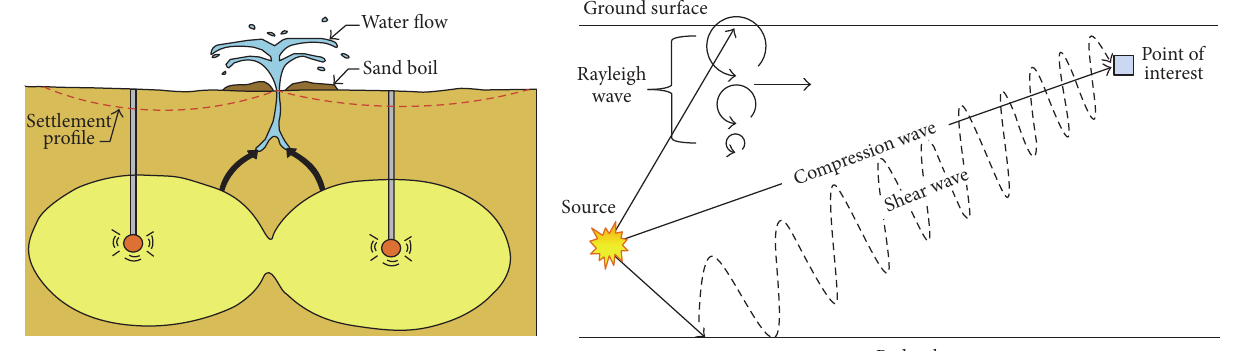
Figure 1: Wave propagation caused by explosion shock, soil liquefaction, and